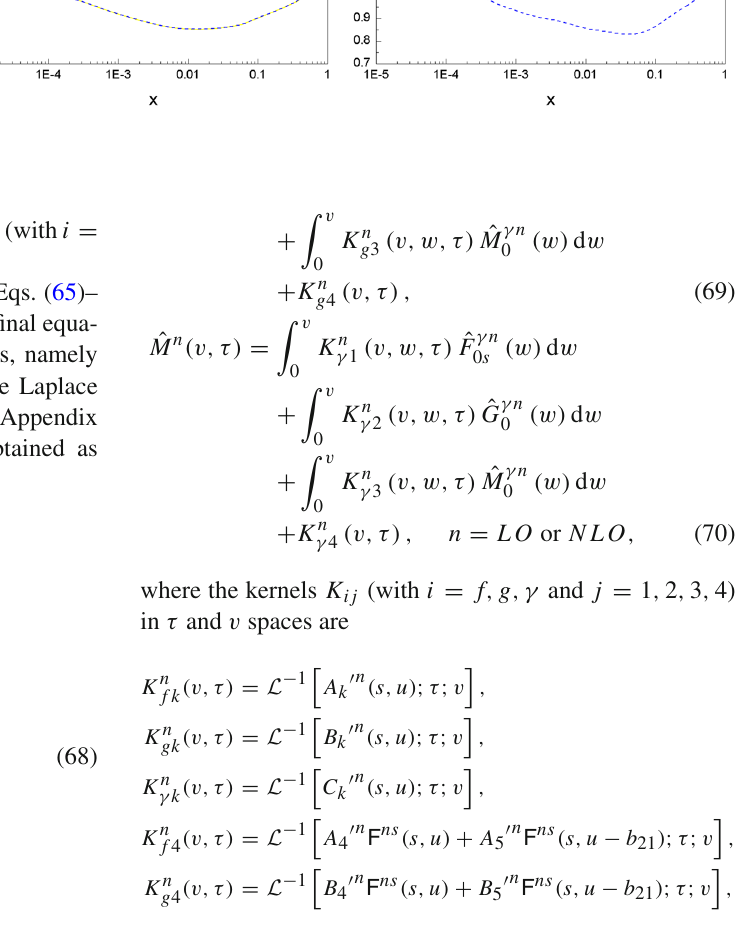
Fig. 2 The ratio F